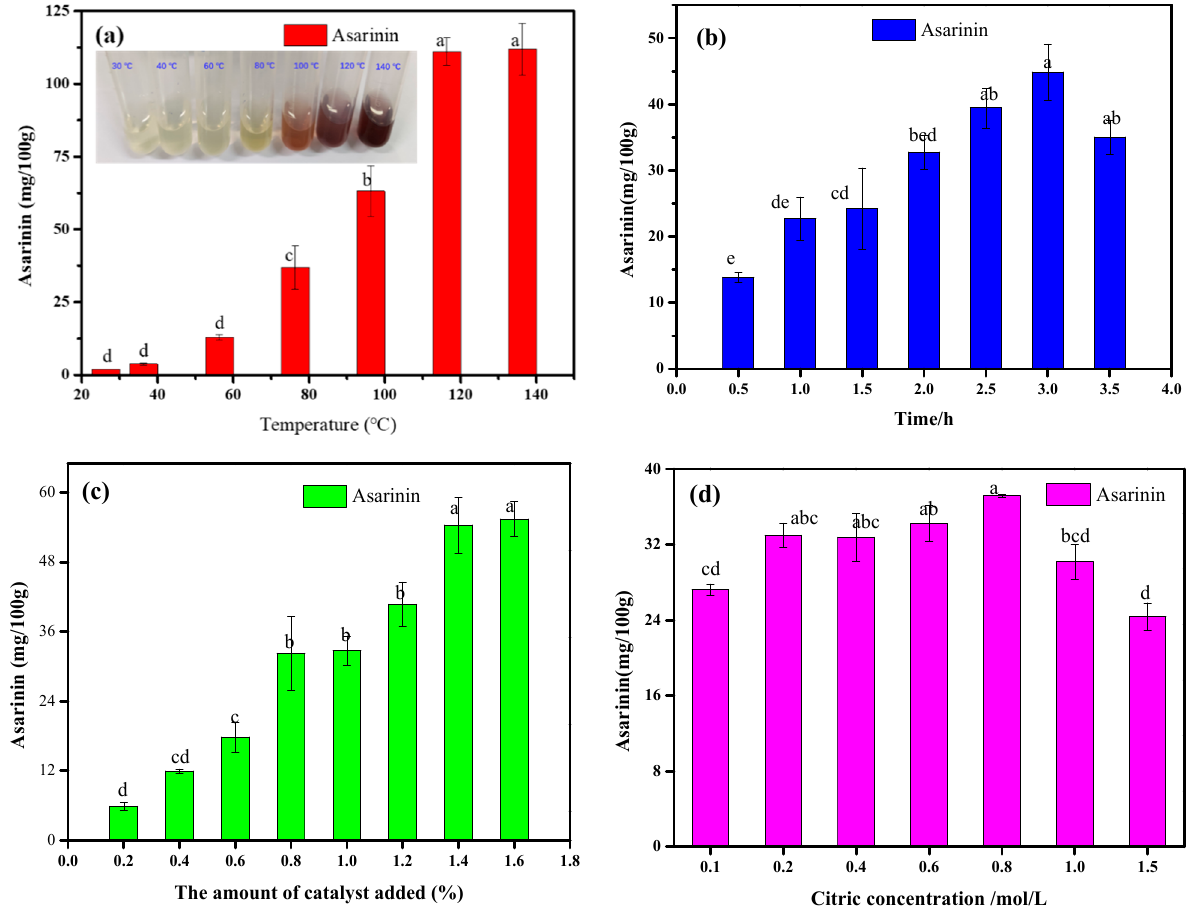
Figure 5. Effects of various reaction conditions on asarinin production: ( a ) catalyst amount, 1.0%; reaction time, 2.0 h; concentration of citric acid loaded on H β , 0.4 mol/L; ( b ) catalyst amount, 1.0%; reaction temperature, 80 °C; concentration of citric acid loaded on H β , 0.4 mol/L; ( c ) reaction temperature, 80 °C; reaction time, 2.0 h; concentration of citric acid loaded on H β , 0.4 mol/L; ( d ) catalyst amount, 1.0%; reaction temperature, 80 °C; reaction time, 2.0 h. Different letters above the bars show significant differences among various conditions.